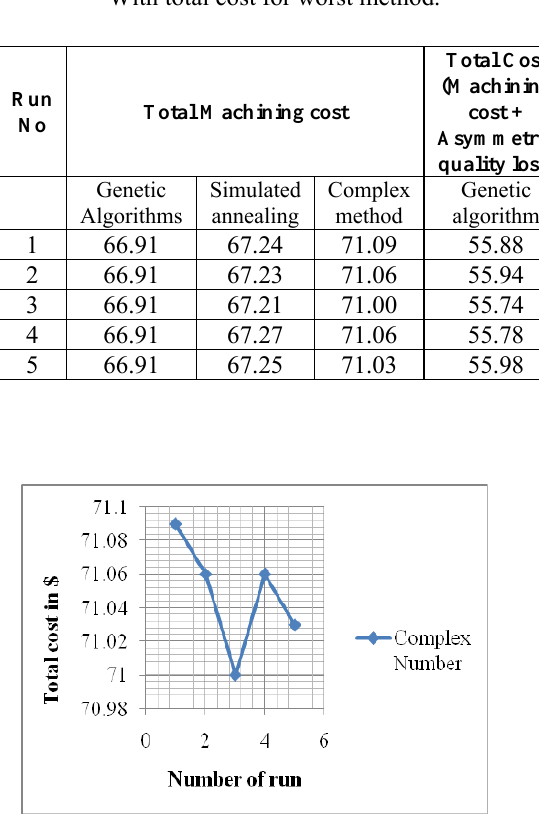
Table 6 Comparison Optimum total machining cost With total cost for worst method.